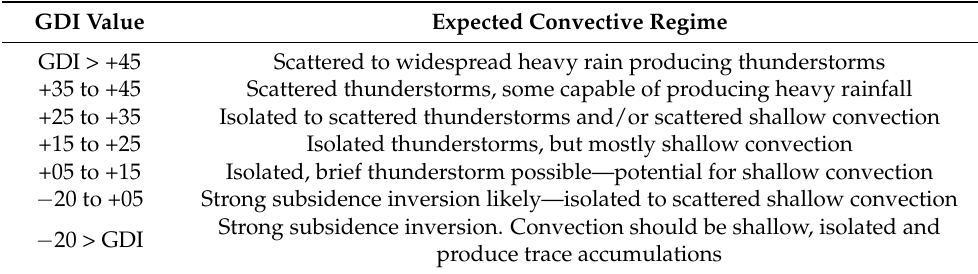
Table 2. Summary of Galvez–Davidson Index (GDI) and expected types of convective regimes based on the Caribbean and surrounding region.